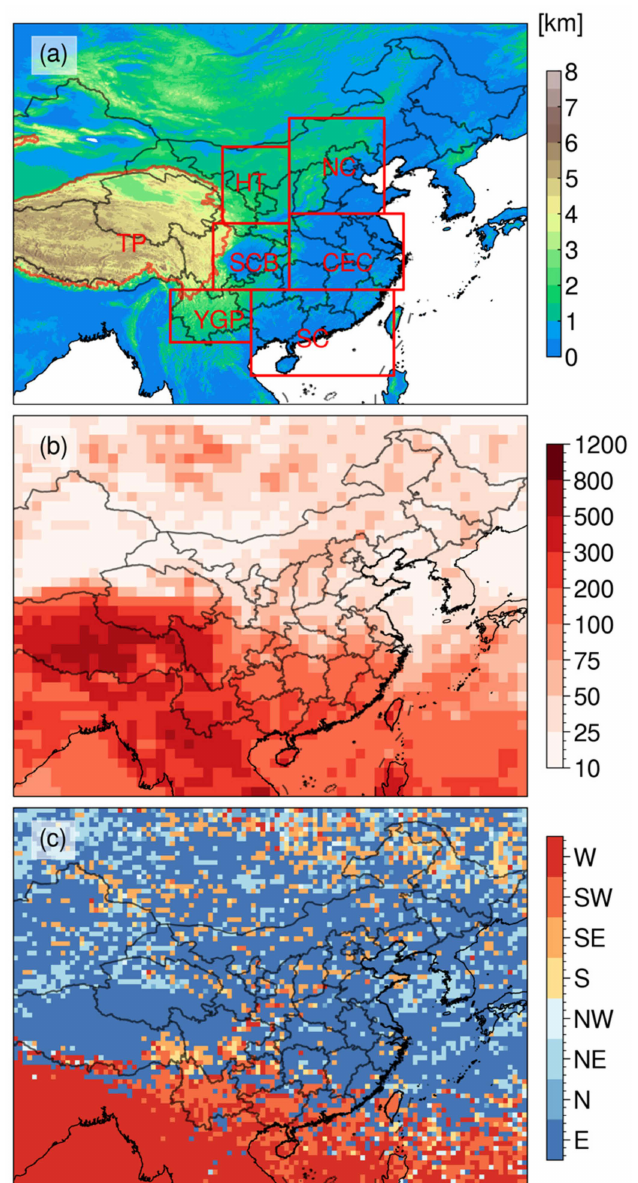
Figure 1. ( a ) China and its vicinity. The filled colors represent terrain height (units: m). The seven sub-regions marked in red rectangles and contours are: HT (Hetao), NC (North China), TP (Tibetan Plateau), SB (Sichuan Basin), CE (Central Eastern China), YP (Yunnan-Guizhou Plateau) and SC (South China) regions. See also in Table 1; ( b ) Mean spatial distribution of convective systems (numbers) on 1 ◦ × 1 ◦ grids; and ( c ) peak propagation direction for deep convective systems on 0.5 ◦ × 0.5 ◦ grids during warm seasons from 2016 to 2020. The peak propagation direction/mean spatial distribution at any grids is accessed from assigning the propagation direction/spatial distribution with the maximum/mean number of convective